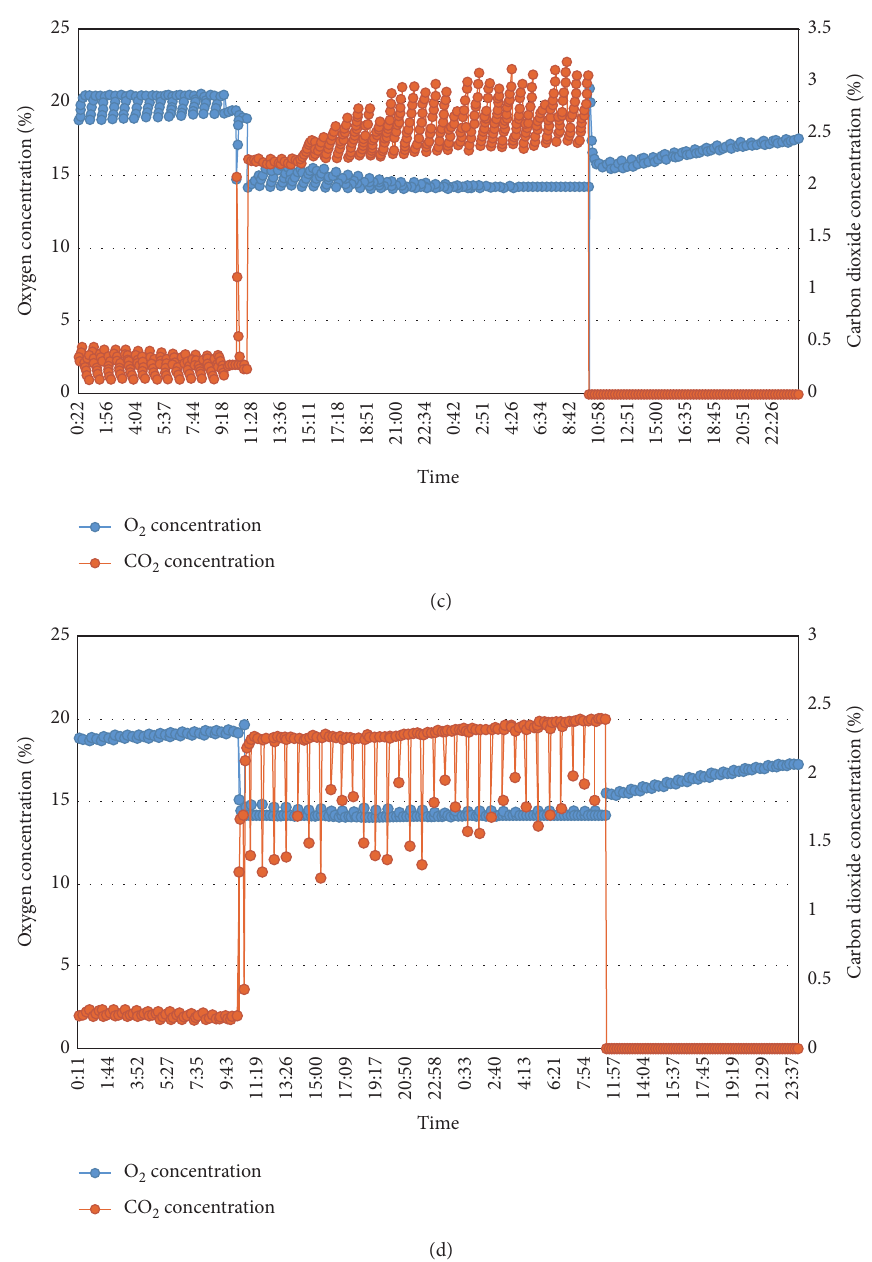
Figure 18: Variation in time of gaseous O 2 and CO 2 concentration upon tests of direct injection of CO 2 in real field. Figures from top to bottom refer to four different observation points, named 29#, 30#, 31#, and